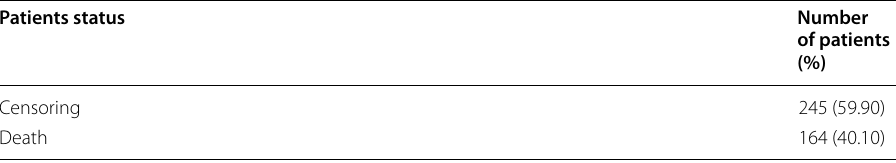
Table 5 Counts for patient status Patients